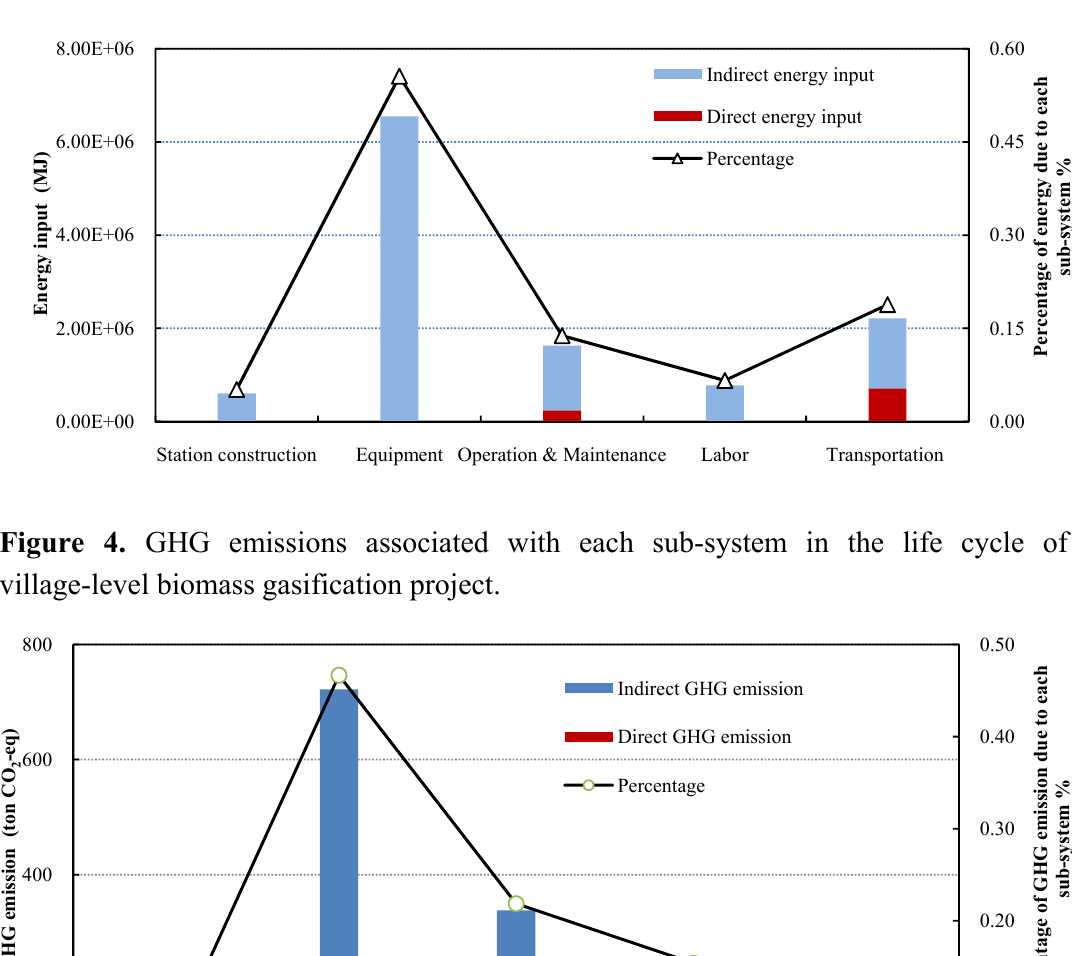
Figure 3. NE cost due to each sub-system in the life cycle of a village-level biomass gasification project.